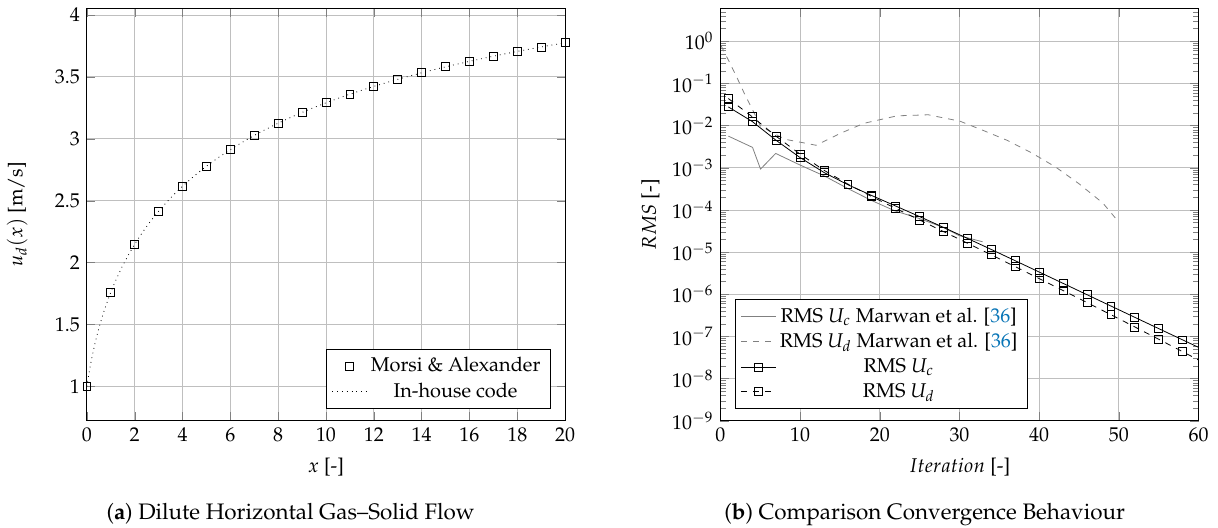
Figure 2. Dilute Gas–Solid Flow: Comparison against analytical solution and reference results of [36].